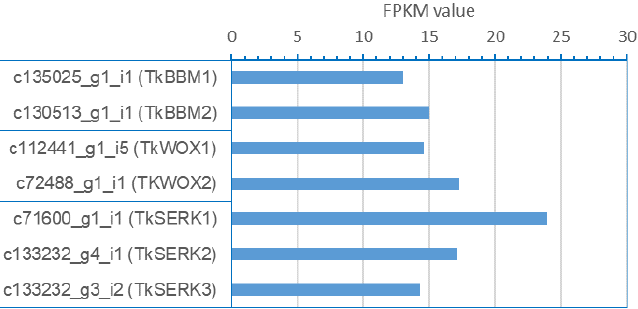
Figure 5. FPKM values of selected contigs of BBM , SERK , and WOX in annotated transcriptome sequences of T . koraiensis embryogenic callus.